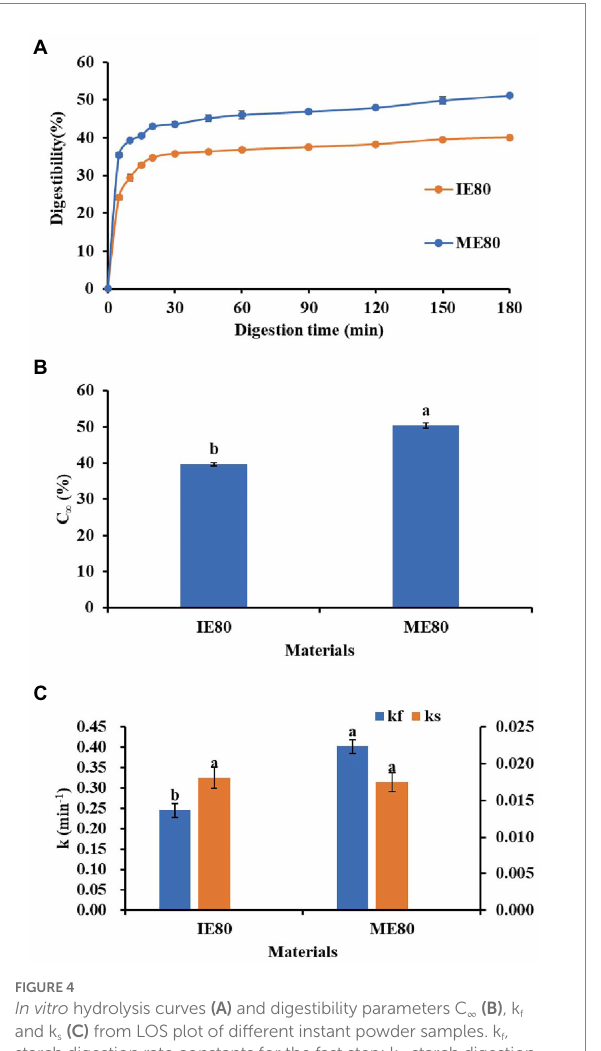
(B) , k f ∞ , the theoretical of starch ∞